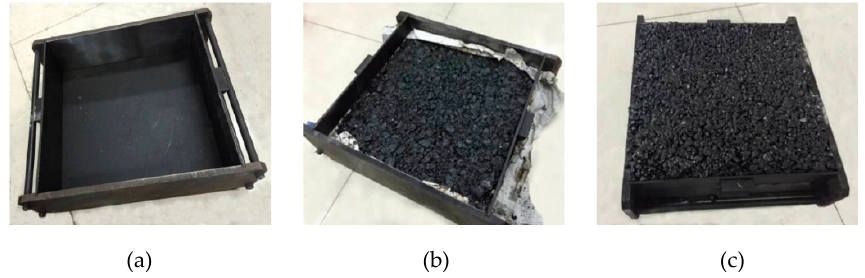
Figure 4. Preparation of the double-layer wheel tracking test specimen. ( a ) The mold for double-layer asphalt mixtures; ( b ) The compaction of the lower layer; ( c ) The compaction of a double-layer asphalt mixture.